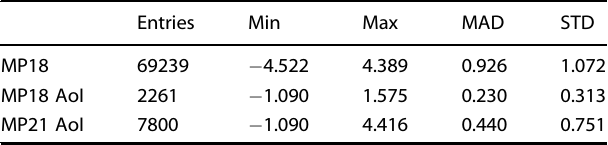
Table 2. Description of the MP18 data and the AoI data in the MP18 and MP21 datasets.